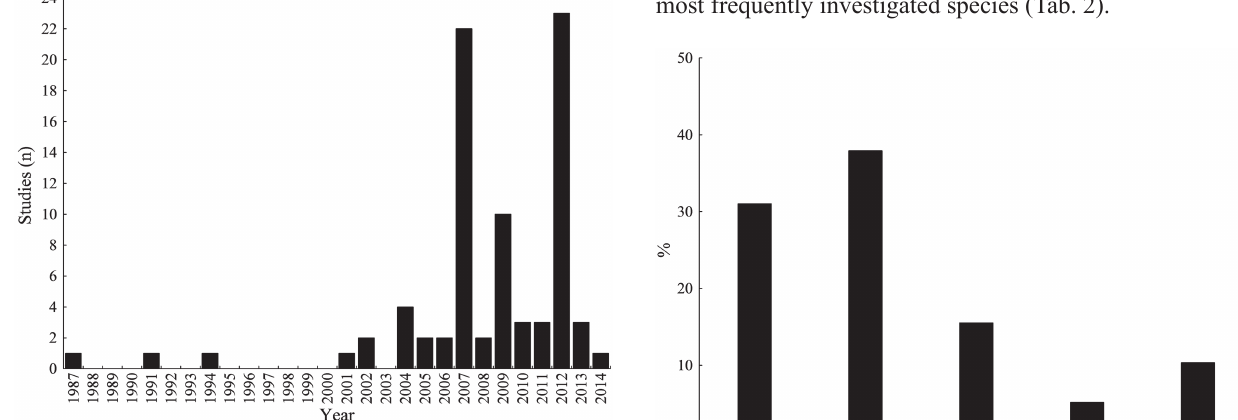
Fig. 4. Number of studies published over the years (1987- 2014) that investigated fish passage facilities in South America. Fig. 5. Time interval (classes) between the beginning of operation of the fish passage and its first evaluation. Studies addressed mainly questions of efficiency (62%), followed by consequence (20 %) and mechanism (16%); very few studies (2%) focused on physiology (Fig.